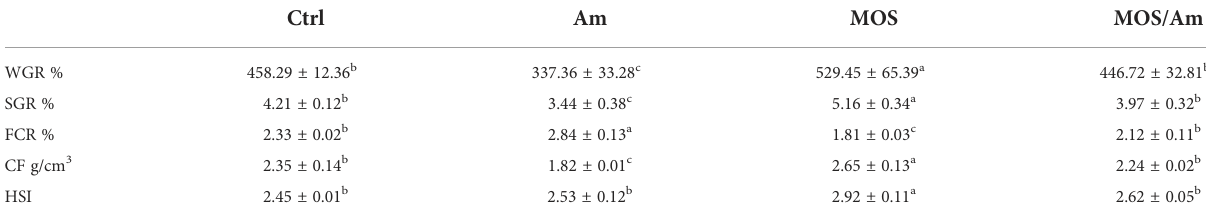
TABLE 4 Effects of dietary MOS on the growth performance of the common carp under ammonia stress for 30 days.